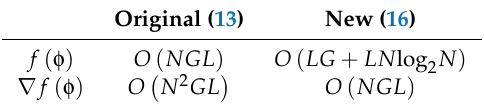
Table 1. The computational complexity using original expression (13) and new expression